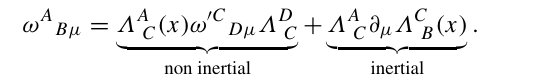
(cid:5) (cid:4) ∂ ,∂ x y